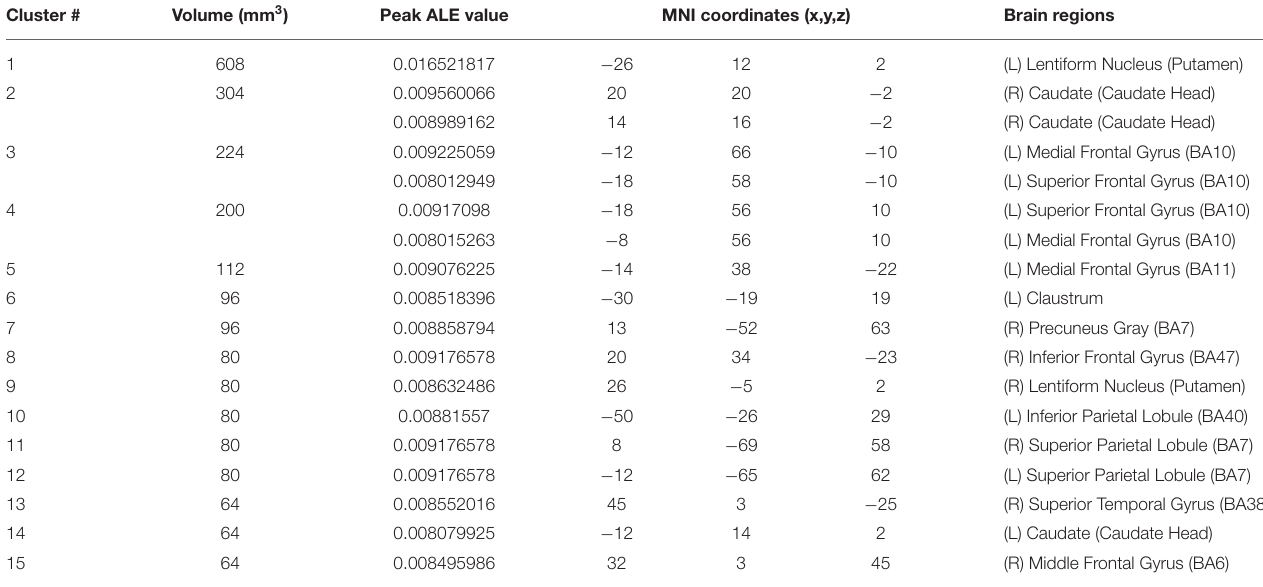
TABLE 4 | Results of ALE analyses on gray matter increase in OCD. Cluster